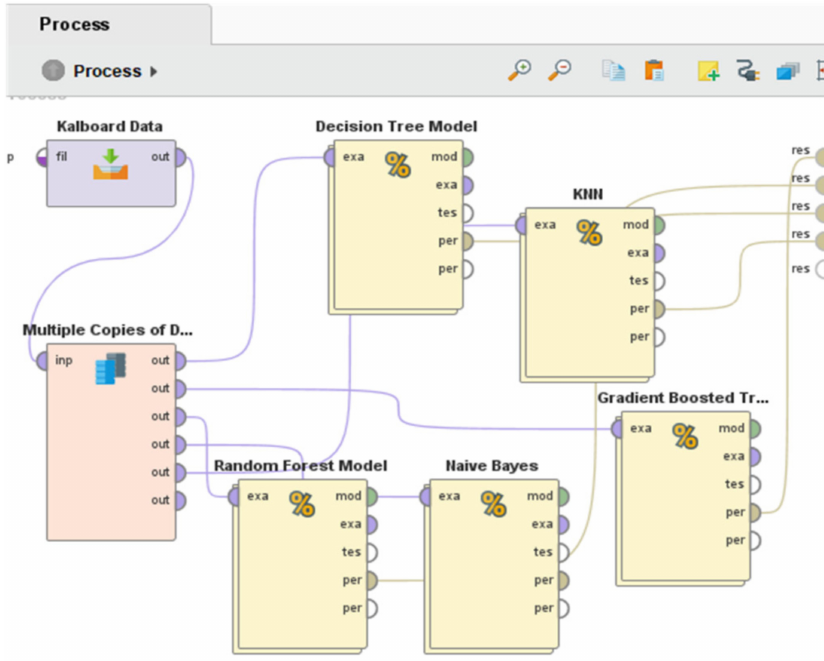
Figure 2. Model implementation without ensemble method (step 1).